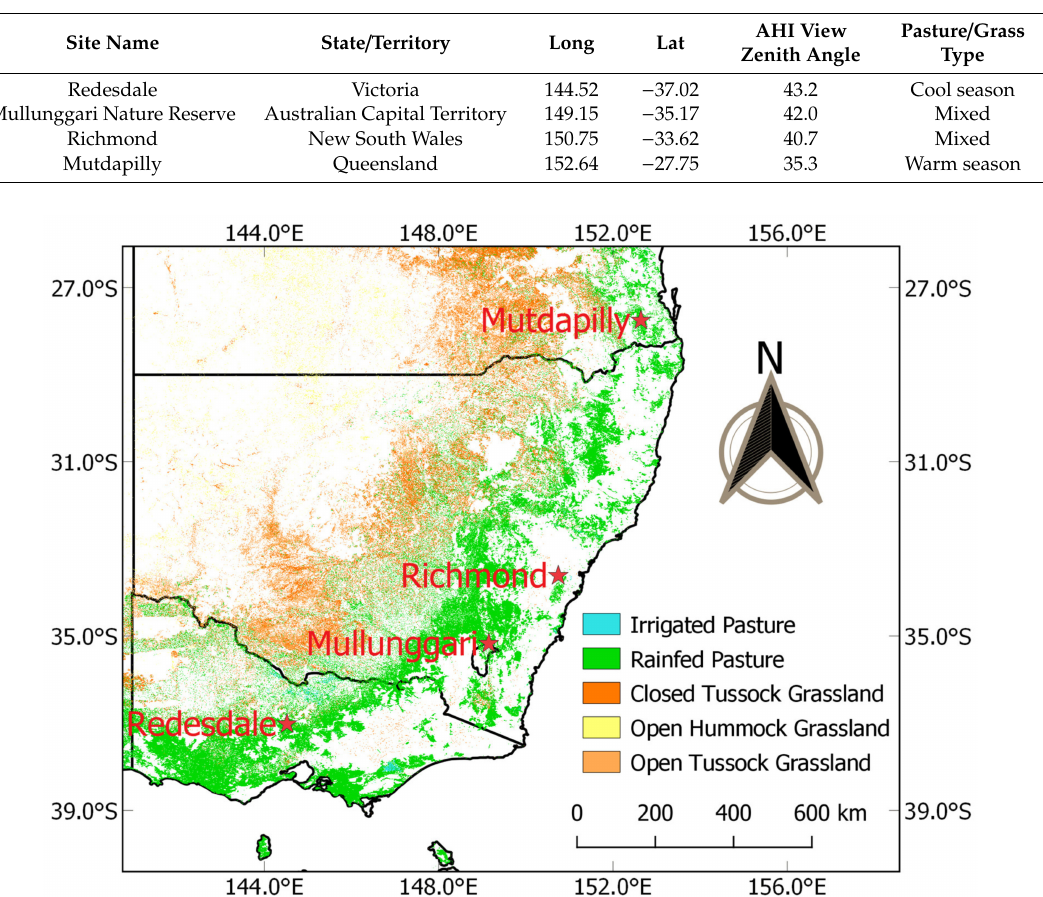
Table 1. Information on location, name, Himawari-8 AHI (Advanced Himawari Imager) view angle geometry, and vegetation type for the four sites used in this study.